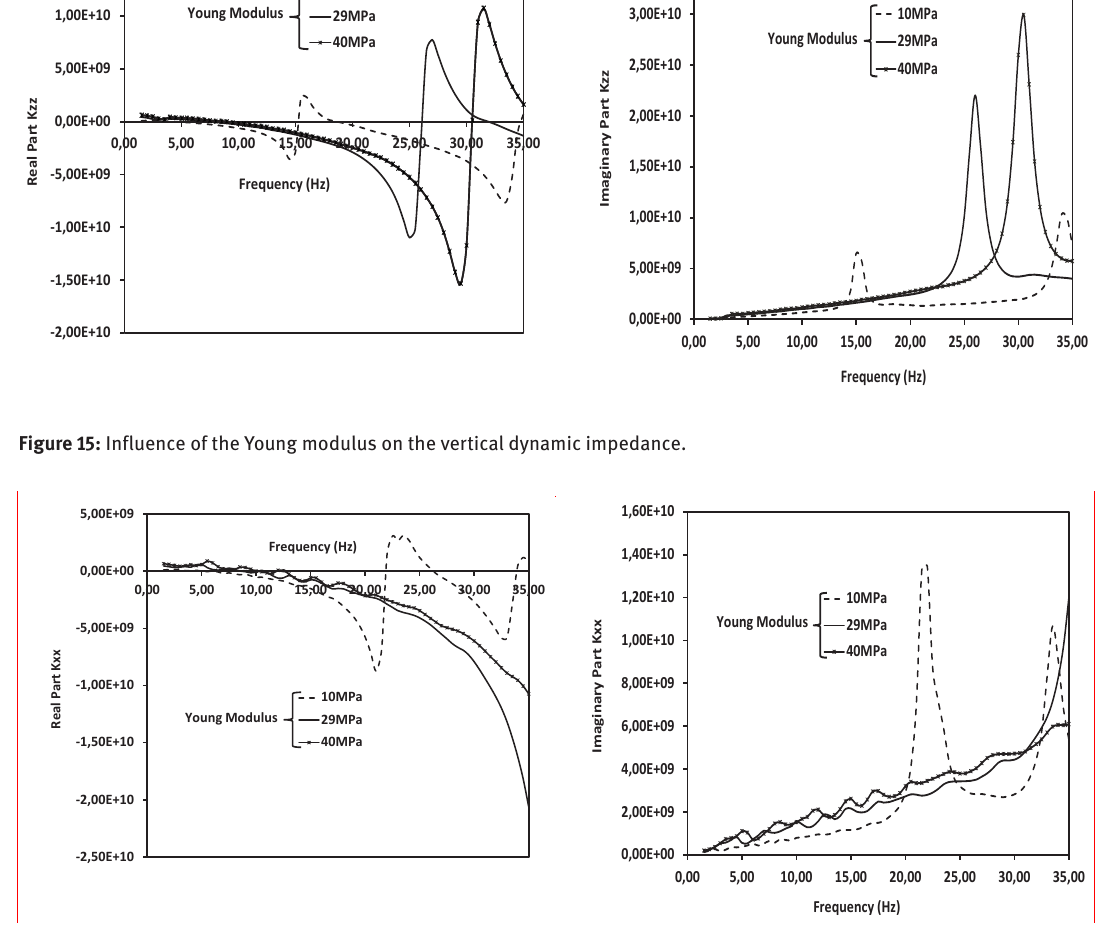
Figure 16: Influence of the Young modulus on the variation of the horizontal dynamic impedance